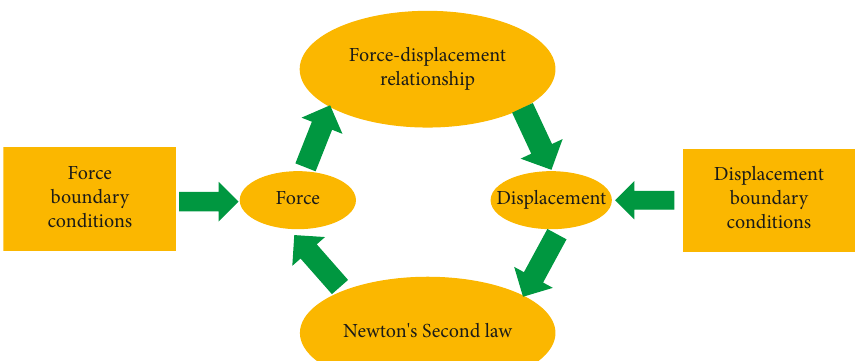
Figure 4: Mechanical principle diagram.